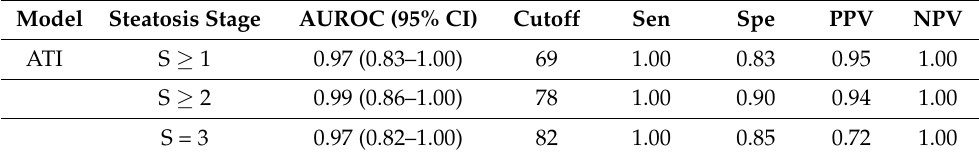
Table 2. ATI values for diagnosing liver steatosis. Model Steatosis Stage AUROC (95% CI)